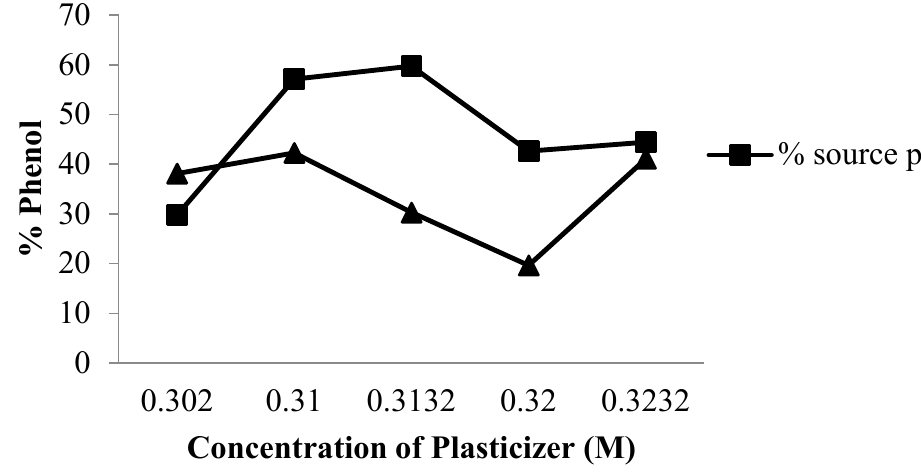
Figure 7. Curve effect of plasticizer